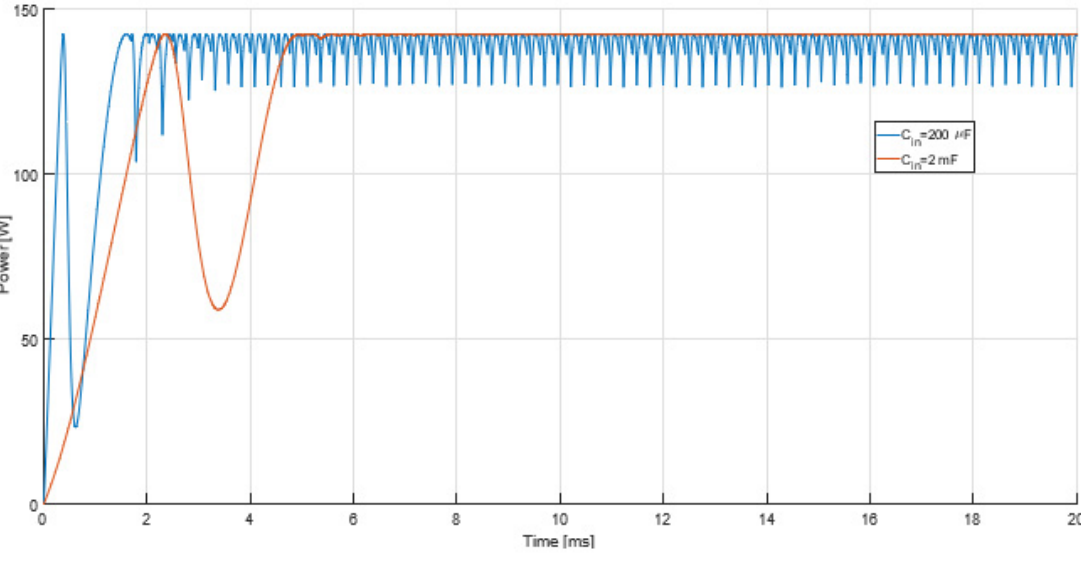
Figure 32. Solar array output power for 3 different decoupling capacitance values.